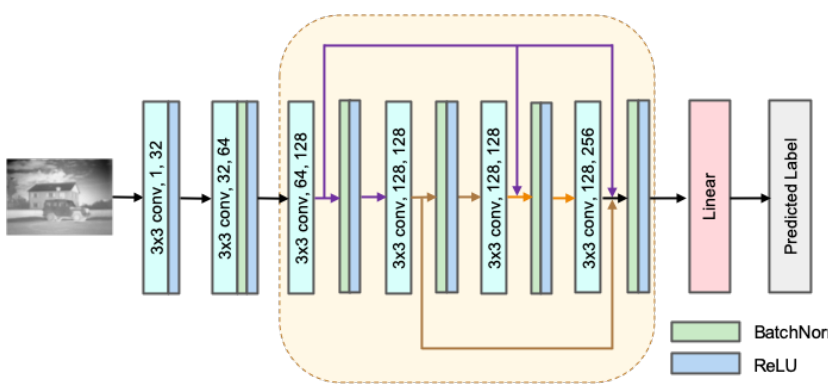
Figure 3. Discriminator network